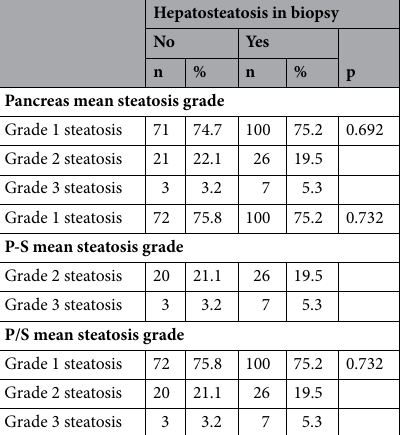
P-S mean steatosis